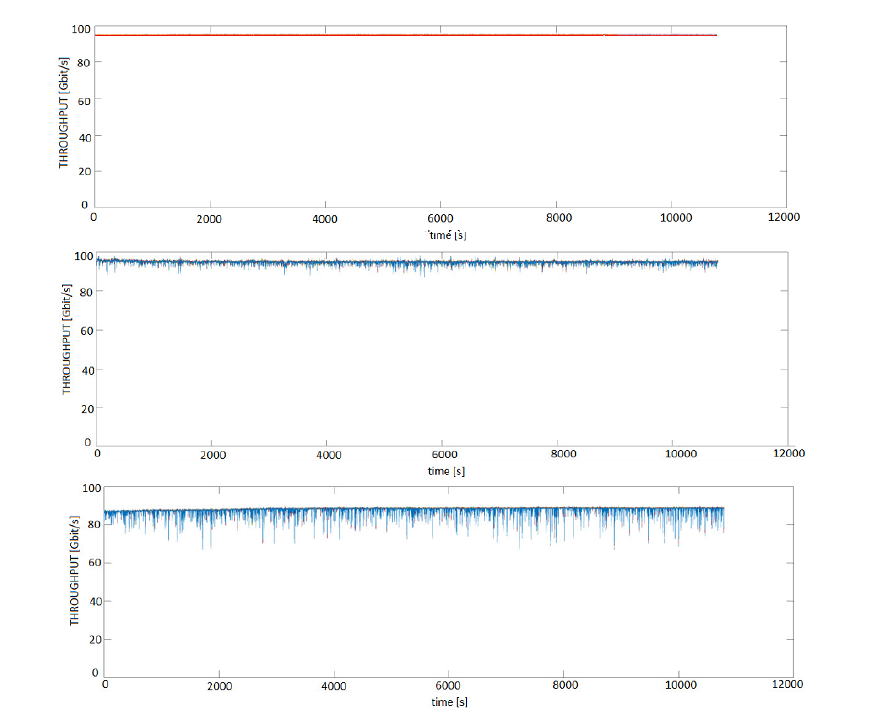
Figure 2. Mellanox InfiniBand (top), Juniper QFX10000-30C RoCE (middle) and Arista DCS- 7280CR2K-30-F RoCE results from Event Builder simulator 2-hour